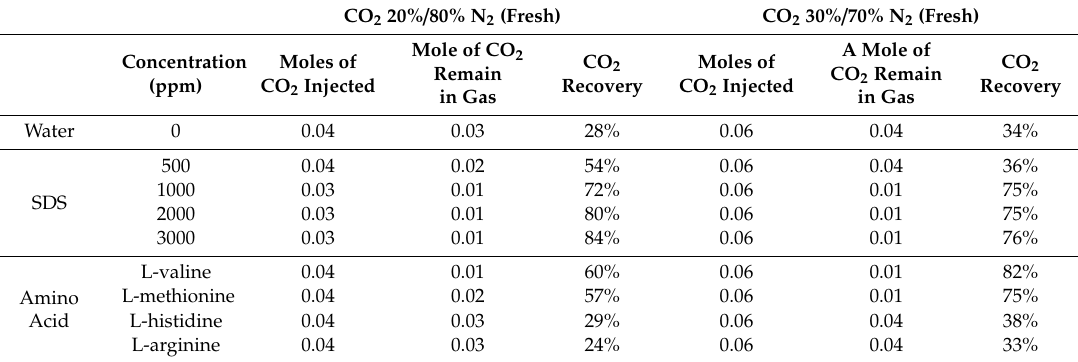
Table 9. CO 2 recovery rate calculated in the presence of di ff erent solution including SDS and selected amino